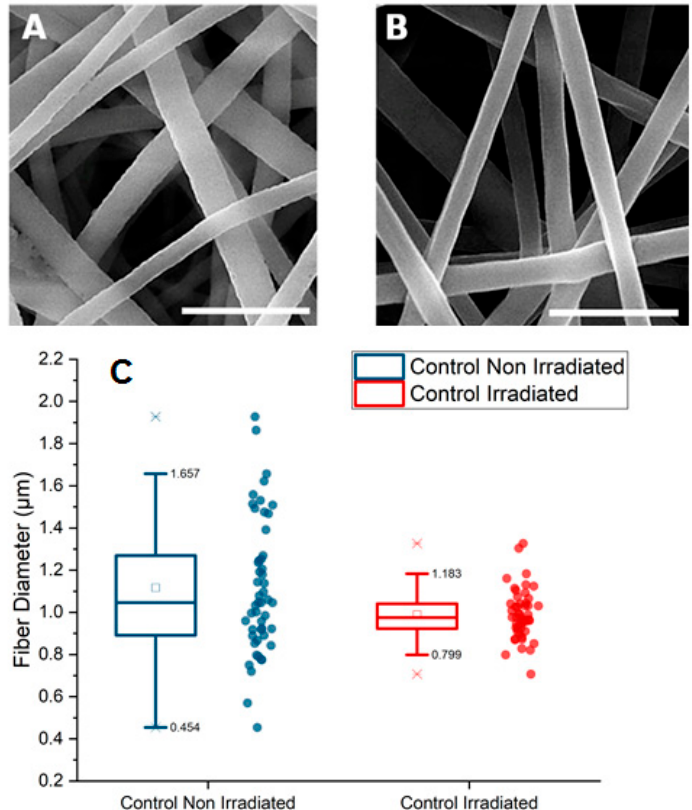
Figure 1. SEM images of control electrospun PLGA nonwoven before in vitro degradation: ( A ) non-irradiated, ( B ) irradiated (Scale bar: 5 µ m) and ( C ) distribution of fibers diameter (mean value of the diameters is represented by a square and median value by a horizontal line in the